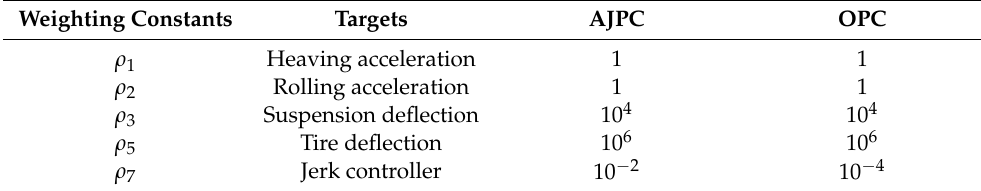
Table 2. Two types weighting factors used in performance